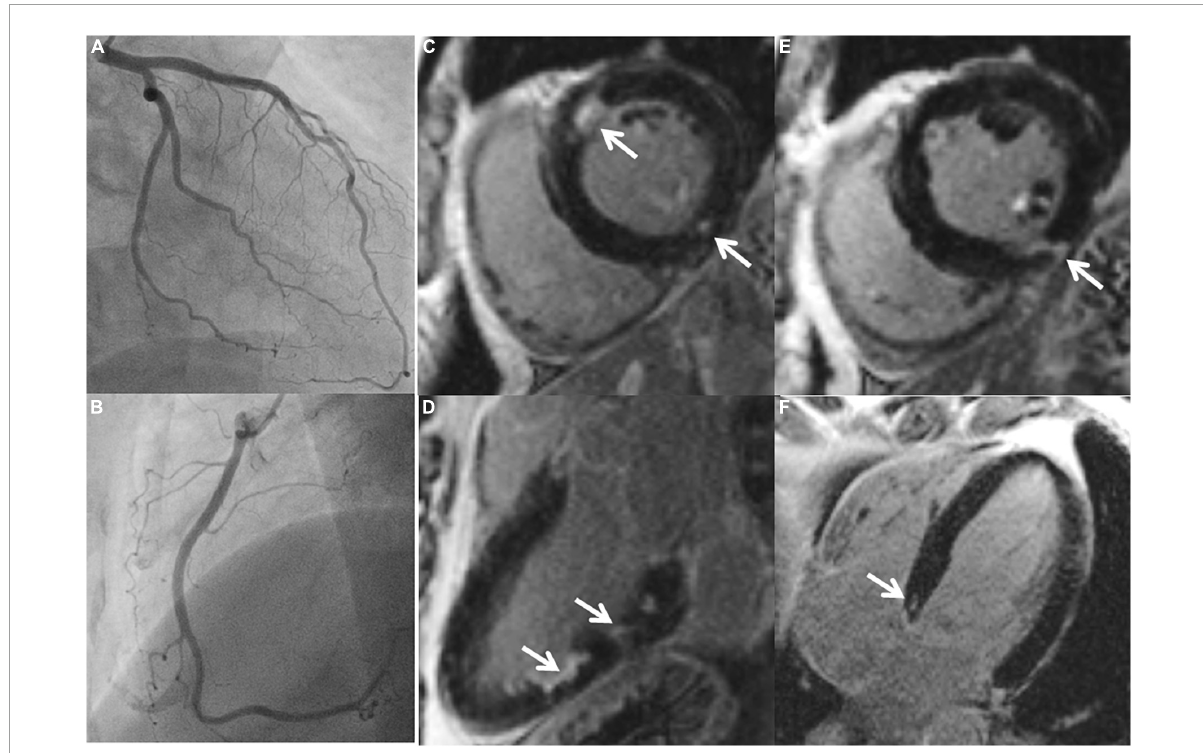
FIGURE1 A 45-year-old male with ischemic stroke, unobstructed coronary arteries and multiple LGE lesions. A 45-year old male with ischemic middle cerebral artery (MCA) stroke (NIHSS 8) successfully underwent systemic thrombolysis. Troponin was increased at admission, maximum 1.18 U/l (reference 0.04 U/l), CK maximum 212 ml/l, chest pain was denied. ECG: sinus rhythm, no ST-segment alterations. Echocardiography showed a preserved left ventricular ejection fraction, no wall motion abnormalities. Cardiovascular risk factors: arterial hypertension. Coronary